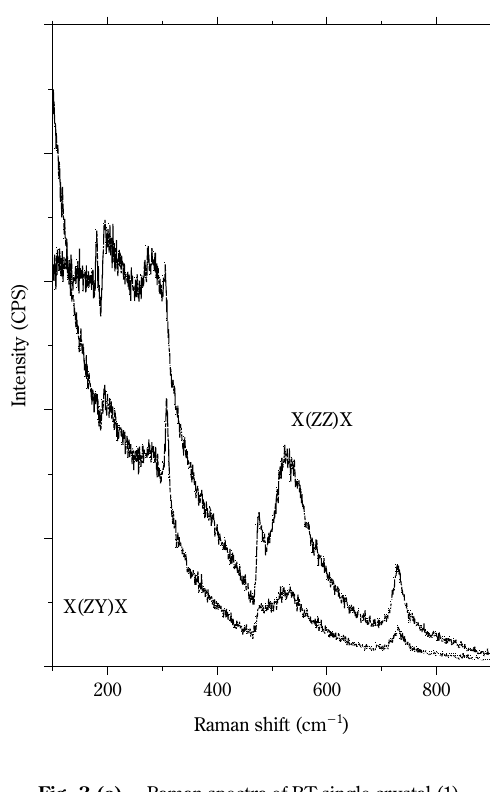
Fig. 3 (a) Raman spectra of BT single crystal (1)